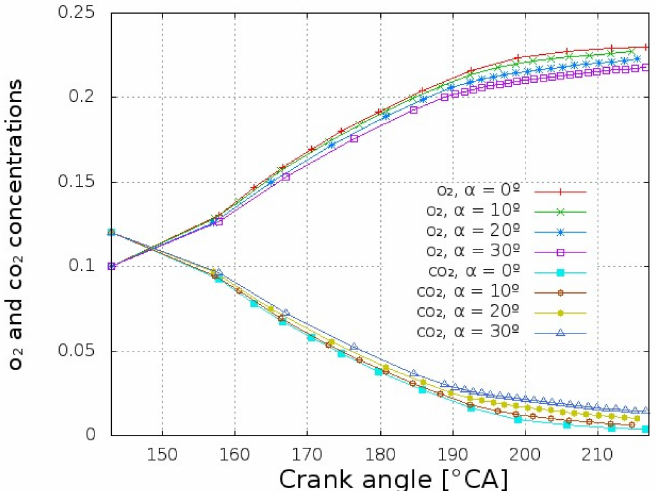
Figure 16. The variation of the concentration of O 2 and CO 2 over time for different scavenging port